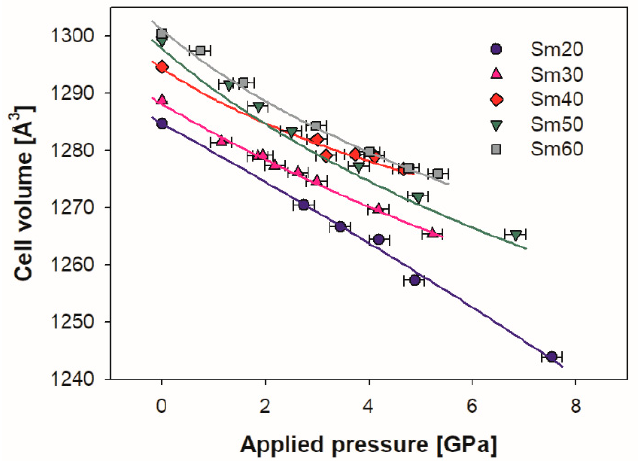
Figure 4. Diffraction patterns of sample Sm50 at all pressure values.